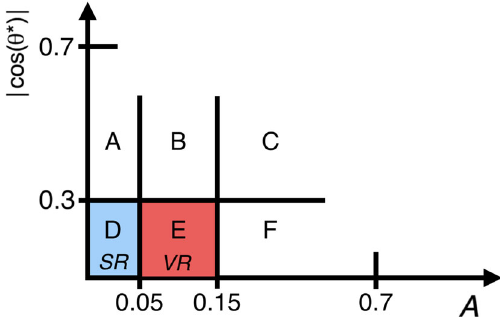
Fig. 5 Definition of the control and validation regions in the A and | cos (θ ∗ ) | plane used to estimate the multijet